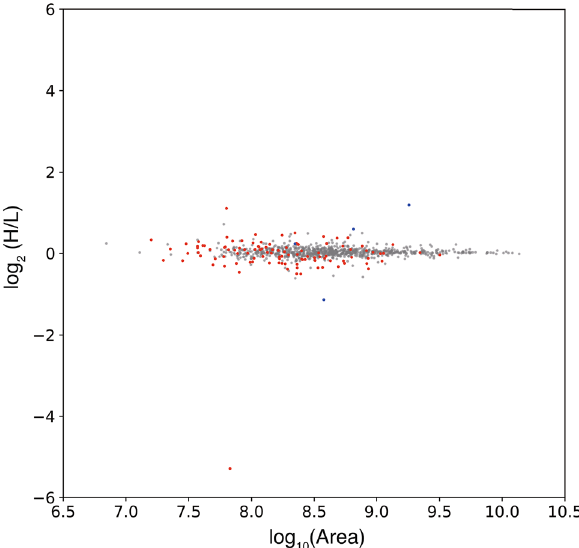
Figure 3. Quantitative analysis using the previous and current strategies. MA plot of peptide pairs extracted using the previous criteria and selected unanimously as true is shown. Peptides only selected unanimously and those classified only using the previous criteria are depicted in blue and red, respectively. Peptides identified by both are shown in grey. Equivalent amounts of light- and heavy-labeled proteins were mixed and then analyzed using LC–MS/MS. Thus, in principle, the peak area of light-labeled peptide would be consistent with the corresponding heavy-labeled peptide, and the log ratio would return to